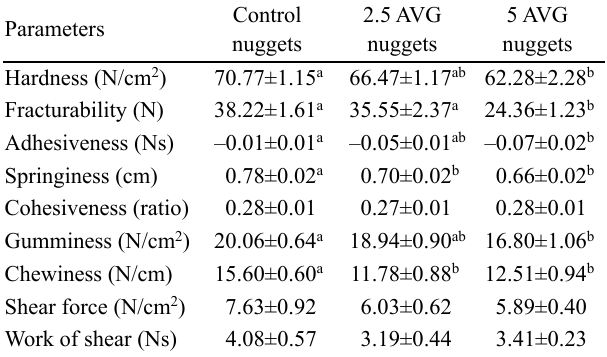
Table 2. Effect of Aloe vera gel addition on the texture profile analysis of goat meat nuggets